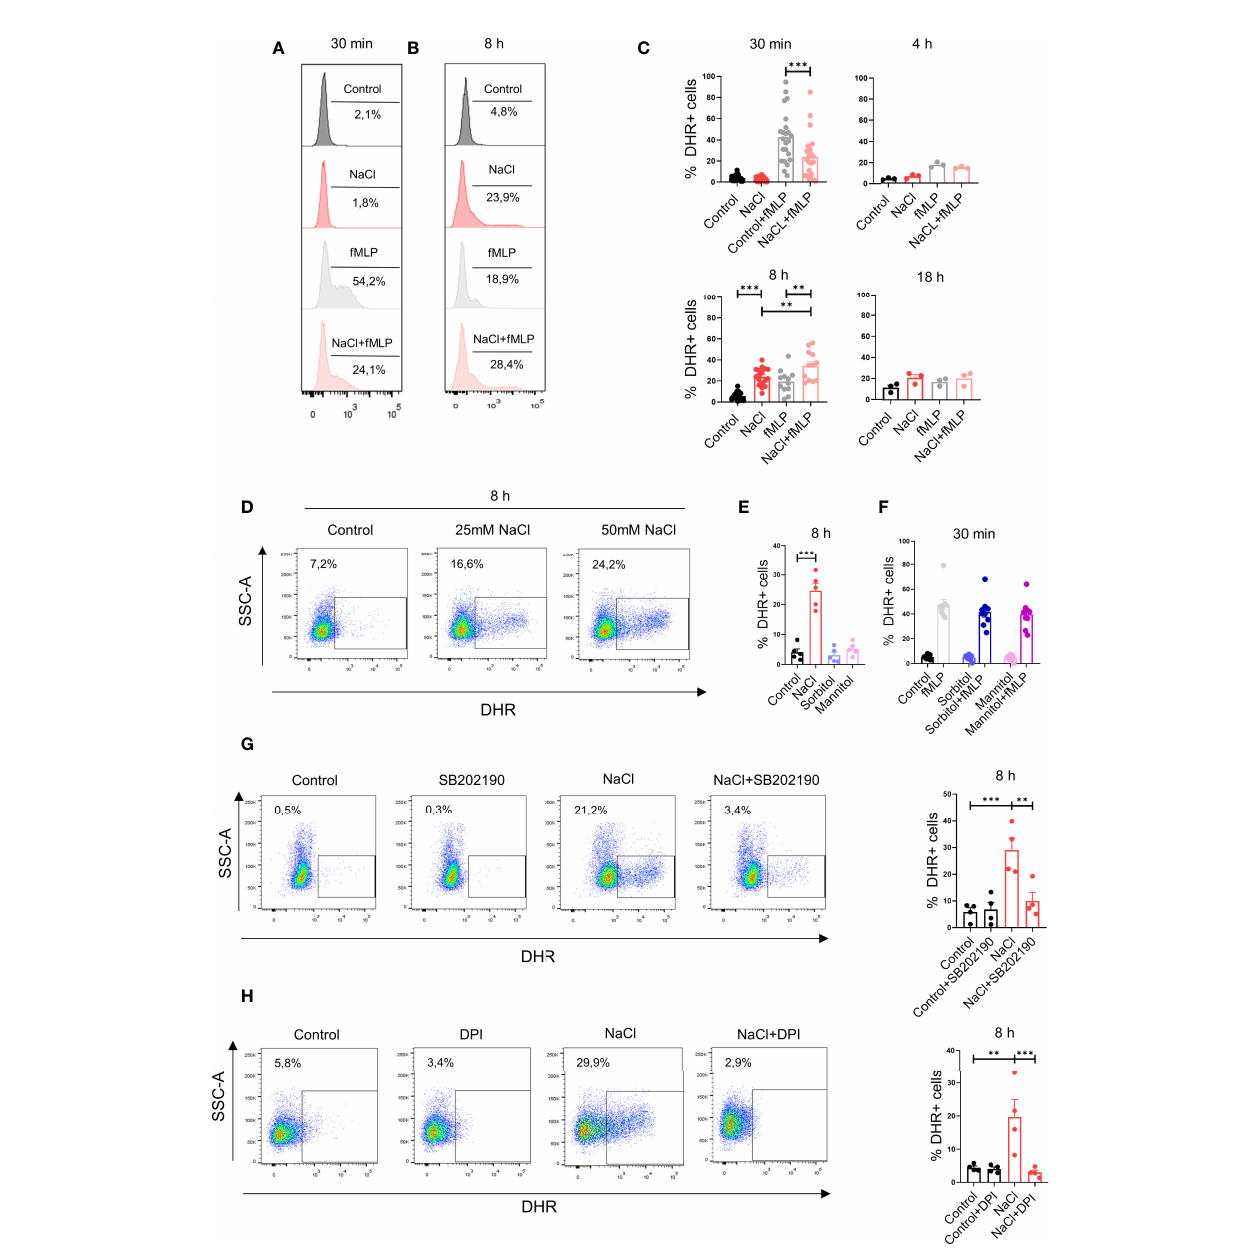
FIGURE 3 | High salt modulates hydrogen peroxide production by neutrophils. (A, B) Neutrophils (2 x 10 6 /ml) were incubated at 37°C for 30 min (A) or 8 h (B) in culture medium supplemented, or not, with NaCl (50 mM). Cells were then labeled with dihydrorhodamine-123 and stimulated, or not, with fMLP (0.5 m M). After 20 min of incubation at 37°C, production of hydrogen peroxide was measured by fl ow cytometry. Representative experiments are shown. (C) Production of hydrogen peroxide was evaluated by fl ow cytometry in neutrophils cultured for different times with or without NaCl (50 mM), fMLP (0.5 m M) or NaCl (50 mM) plus fMLP (0.5 m M). Results are expressed as the mean ± SE from 14, 3, 17, and 3 experiments, for time points of 30 min, 4 h, 8 h and 18 h, respectively. (D) Neutrophils were incubated by 8 h in culture medium supplemented with 25 or 50 mM NaCl and the production of hydrogen peroxide was then evaluated. A representative experiment is shown. (E) Neutrophils were incubated for 8 h in culture medium supplemented with 50 mM NaCl, Sorbitol or Mannitol (100 mM) ( fi nal osmolarity of the culture) supplemented medium = 400 mOsm). Then, the production of hydrogen peroxide was evaluated. Results are expressed as the mean ± SE of 5 experiments. (F) Neutrophils were cultured for 30 min in culture medium supplemented, or not, with sorbitol or mannitol (100 mM) and/or fMLP (0.5 m M). Then, the production of hydrogen peroxide was evaluated. Results are expressed as the mean ± SE from 9 experiments. (G , H) Production of hydrogen peroxide was evaluated by fl ow cytometry in neutrophils cultured for 8 h in culture medium supplemented with 50 mM NaCl, in the absence or presence of the p38 MAPK inhibitor SB202190 (10 m M) (G) or the NADPH oxidase inhibitor diphenyleneiodonium (DPI, 10 uM) (H) . Representative experiments and the mean ± SE from 4 experiments are shown. ** P <.01, and *** P